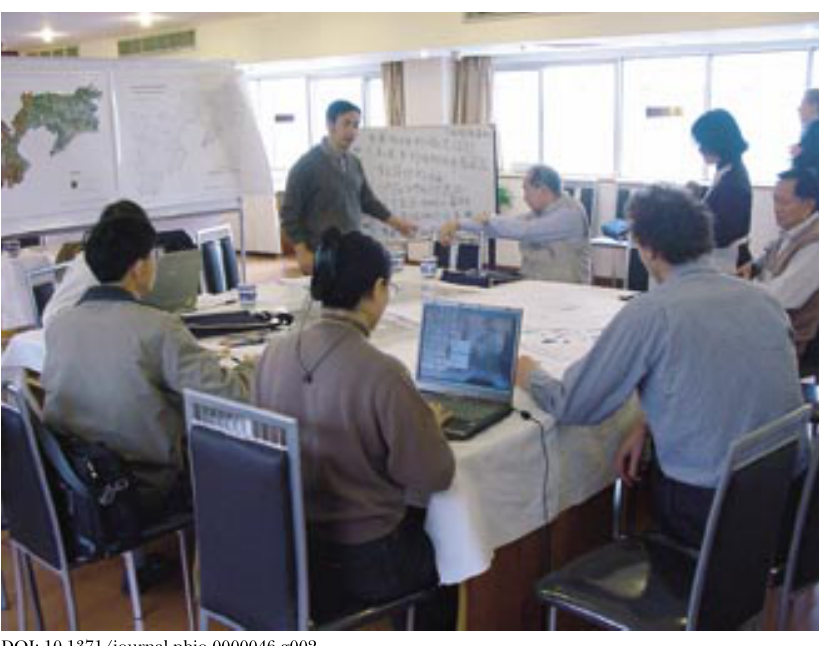
Figure 2. Conservation Priority Setting Workshop In partnership with scientists and institutions around the world, CABS researchers are increasingly making use of open-access databases, species lists, and other types of biological information to identify global and regional priorities, to address upcoming threats, and to monitor the results of conservation interventions. (Photograph by Carly